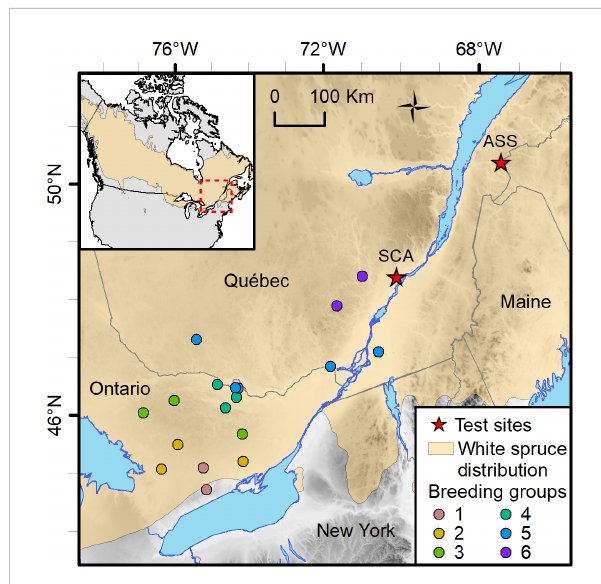
FIGURE 1 Location of the St. Casimir (SCA) and Asselin (ASS) white spruce test sites in the province of Que ́ bec, Canada. The provenances of the genetic material tested in both sites are colored by breeding groups. Each breeding group is composed of two to fi ve